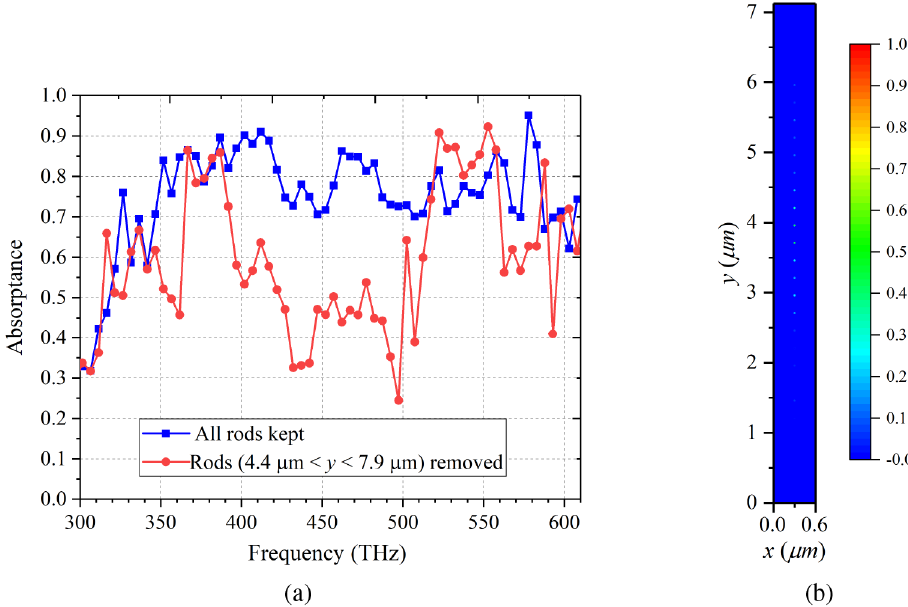
Fig. 6. (a) Absorptance spectrum (in blue) for a TM polarized light incident on a structure whose unit cell has size a x =600 nm, and consists of a single column of 19 Rh rods separated by a y = 250nm. The red curve corresponds to the absorptance spectrum when the rods having 2 : 69 m m < y < 4 : 43 m m are removed. (b) 2D color contour plot for the normalized volume density of power dissipation ( J ⋅ E (cid:4) ) in the case of a TM polarized light of frequency f =440 THz incident on the structure mentioned in (a), before removing any rods.